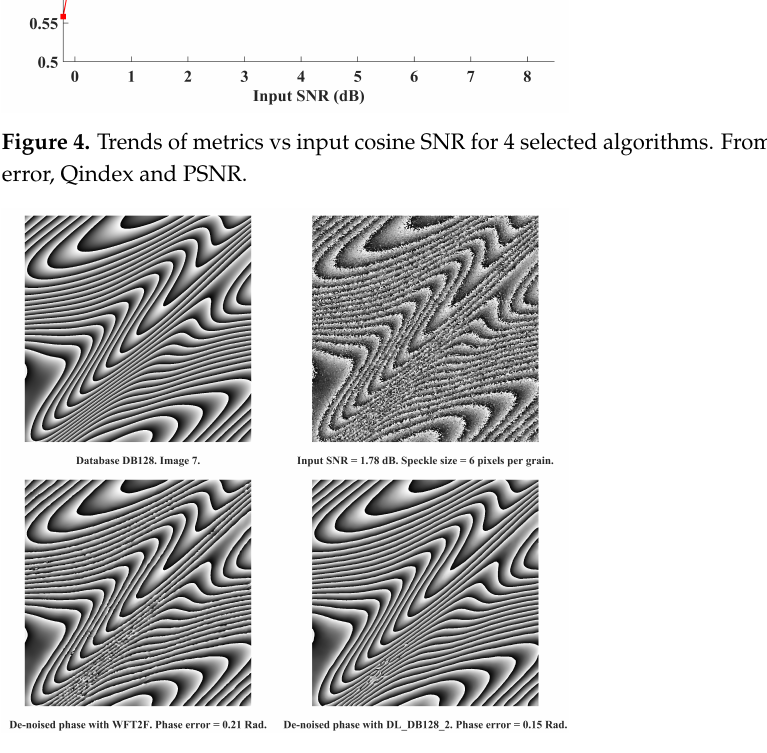
Figure 5. Comparison between WFT2F and DL_DB128_2 with image 7 of DB128-train database. From left to right and top to bottom : noise-free phase, noisy input phase, de-noised phase with WFT2F and DL_DB128_2. Cosine input SNR is − 0.2 dB. Phase error with WFT2F is 0.21 rad. Phase error with DL_DB128_2 is 0.15